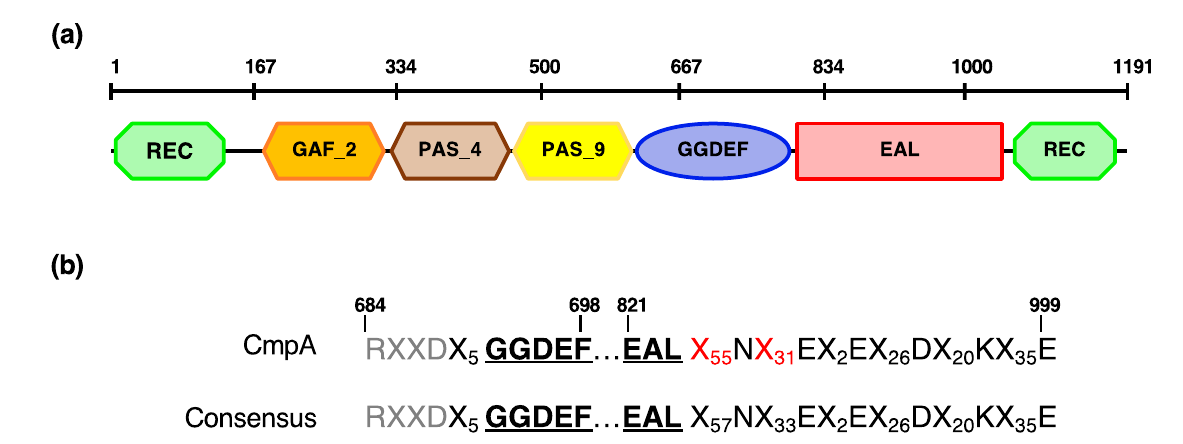
Figure 3. ( a ) Distribution of functional domains present in CmpA protein; ( b ) conservation of GGDEF and EAL domains. Numbers indicate positions of amino acid residues from first methionine. Residues corresponding to RXXD motif, responsible for allosteric control and present in other proteins that contain GGDEF domains, are indicated in gray. Table 5. Protein homologs to CmpA from Pseudomonas alcaligenes AVO110 in other